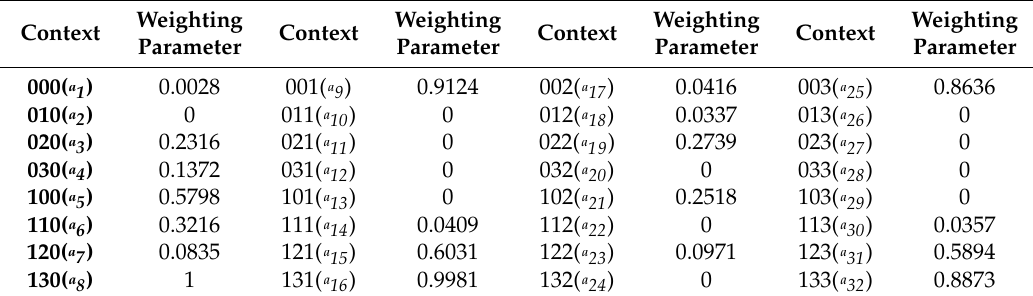
Table 3. The context weighting parameter values studied by the genetic